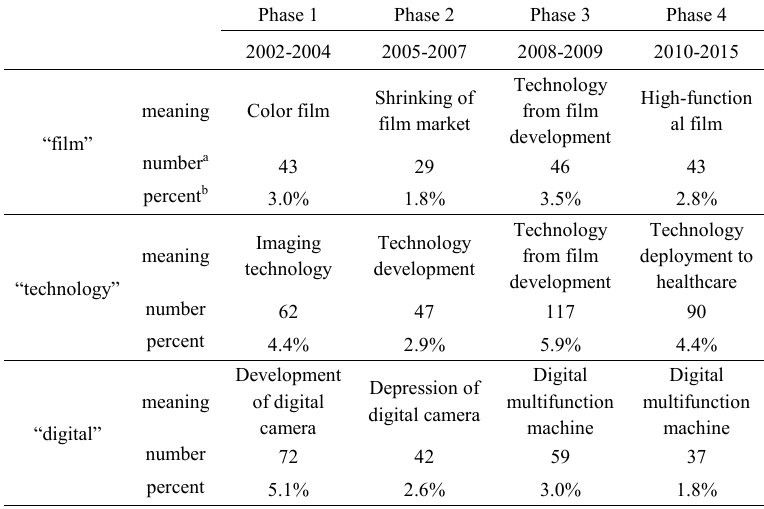
Table 1. Changes of words’